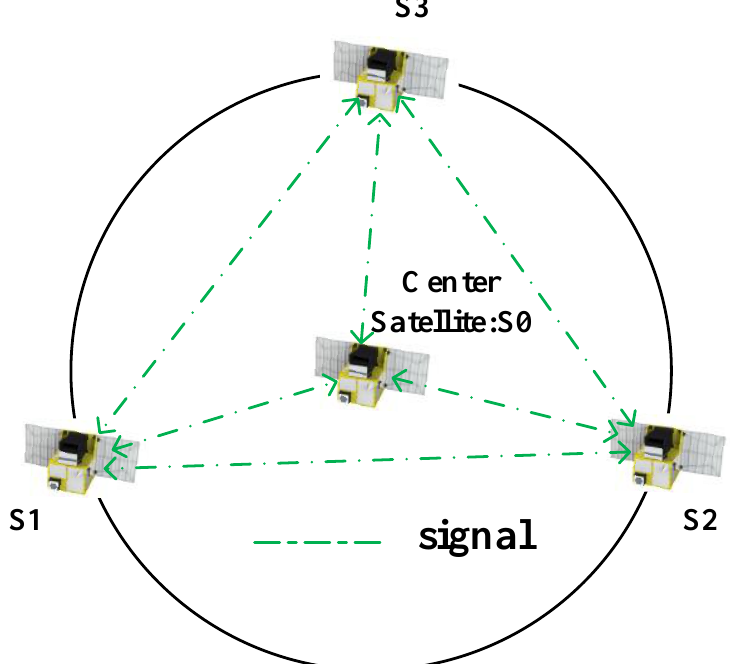
Figure 4. Circular formation.